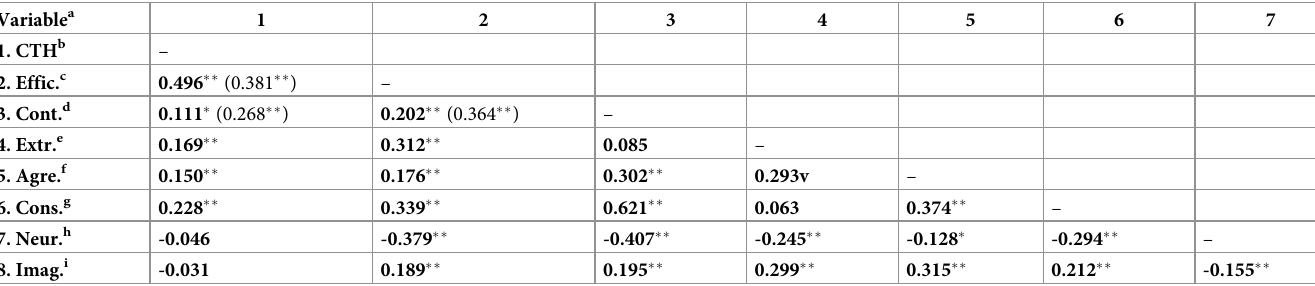
Table 2. Correlation